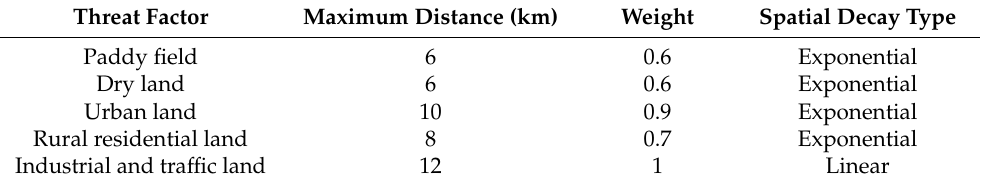
Table 2. Attributes of threat